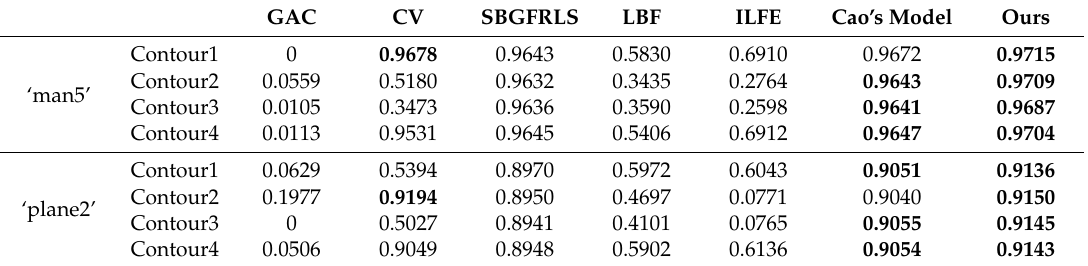
Table 6. Statistic of F values (‘man’ and ‘plane’ image), and bold values indicate the top two results.